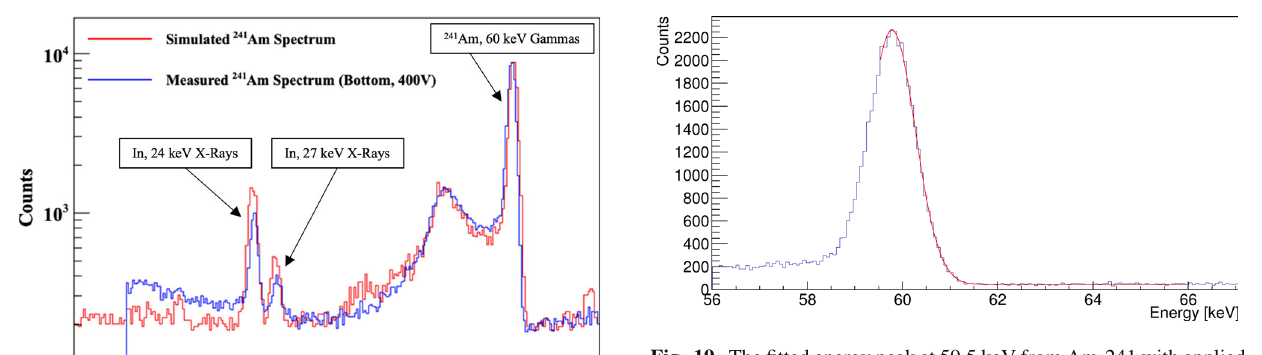
Fig. 19 The fitted energy peak at 59.5 keV from Am-241 with applied voltageat400Vwhenthesourcewasplacedatthebottomofthecryostat